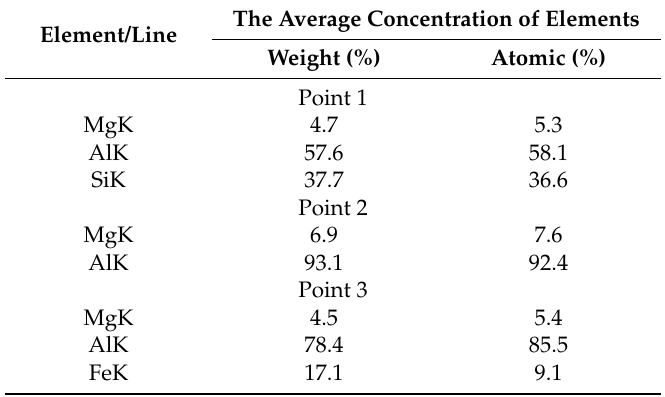
Figure 2. Secondary electron image of a solution-treated AlMg5 alloy ( a ) and corresponding EDS spectra of the analysed phases ( b ). Table 2. Results of energy-dispersive X-ray spectroscopy (EDS) chemical composition microanalysis.